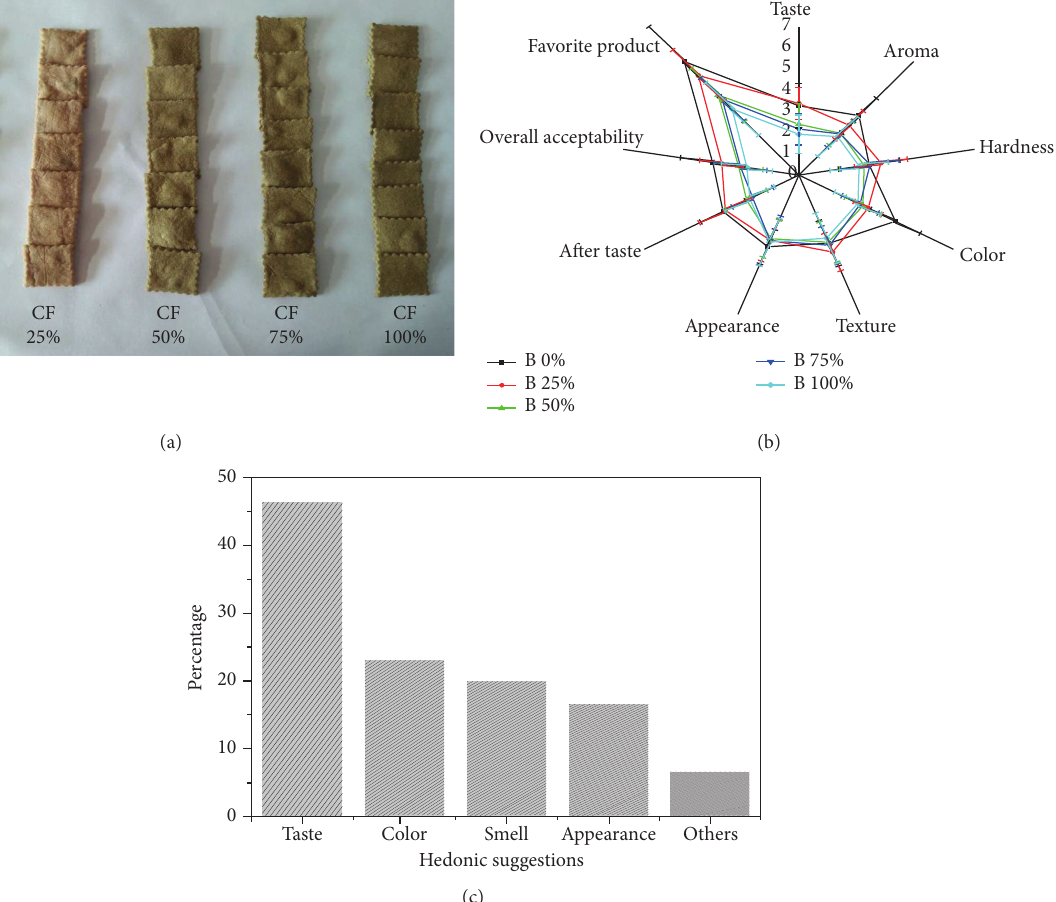
Figure 4: (a) Photographs of biscuit with levels of supplemental CF. (b) Sensory profile of composite biscuits. (c) Rate of suggestions improving the acceptability of